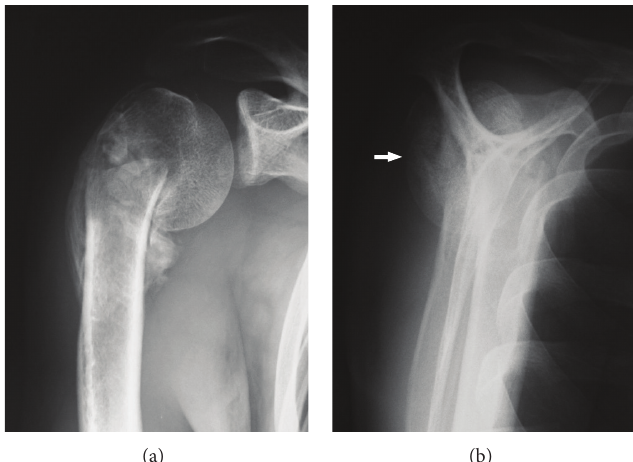
Figure 1: Preoperative anteroposterior (a) and scapula-Y (b) radiographs demonstrate varus and retroversion (arrow) deformity of the humeral neck.